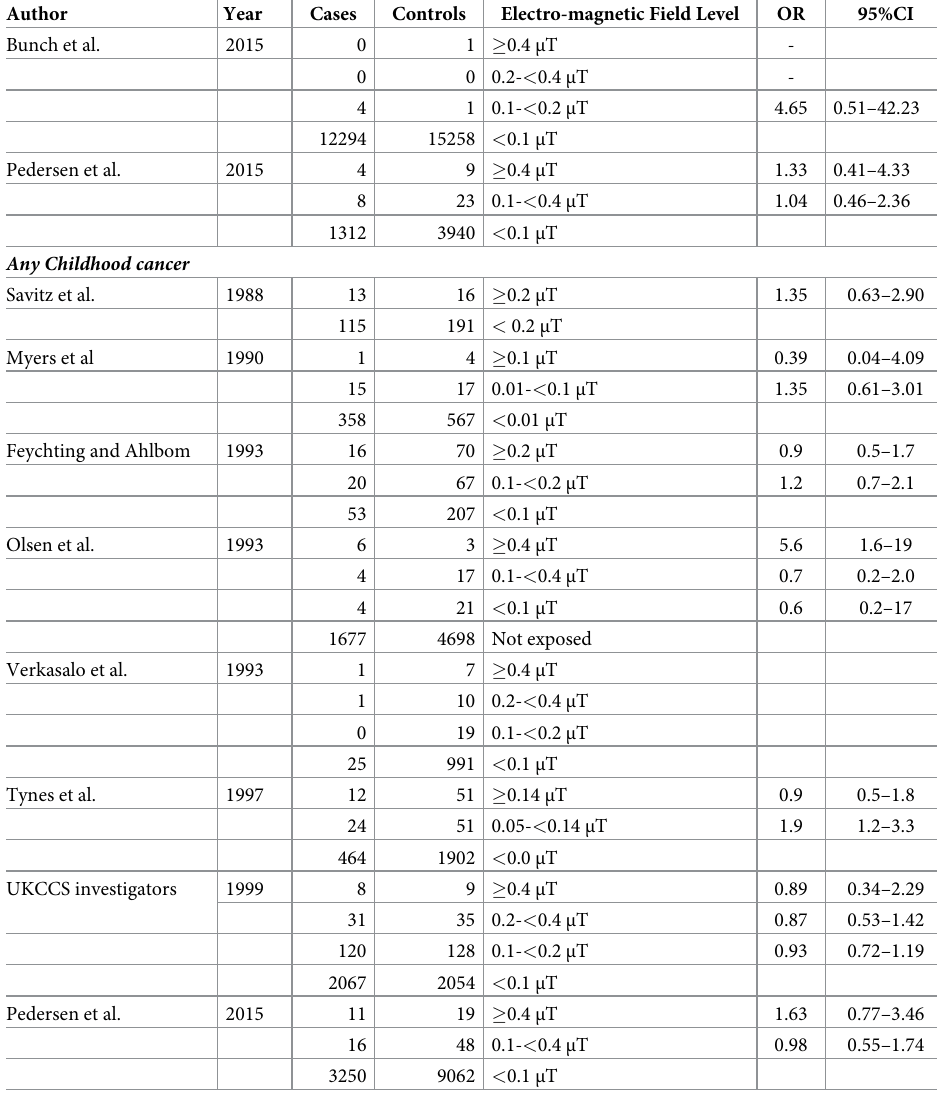
Table 3. A total score of 7 and more indicated high-quality